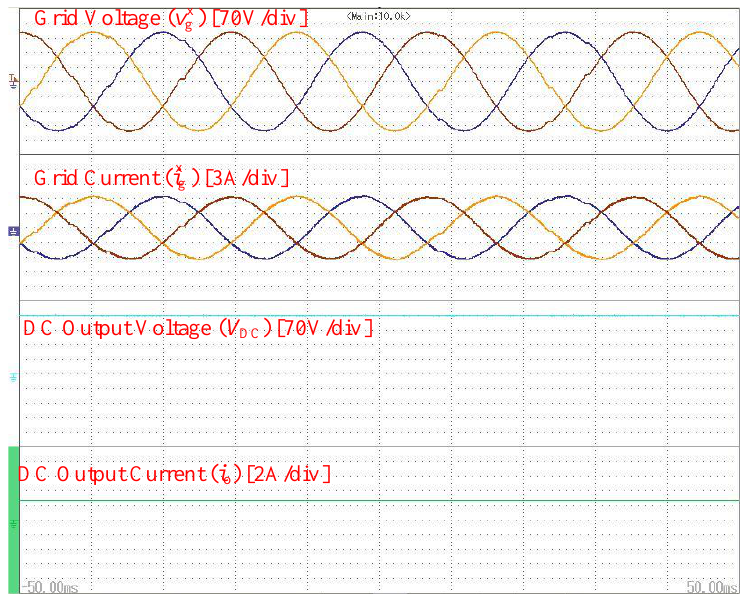
Figure 13. Steady-state experimental waveforms in the boost mode operation of the proposed rectifier. The proposed multilevel rectifier operates in buck mode of operation. In the input, terminals of the rectifier generate four-level as a pole voltage ( V xn ) with levels of 0, + V DC , +2 V DC , +3 V DC . Moreover, seven-level is generated as a line voltage ( V ab , V bc , V ca )